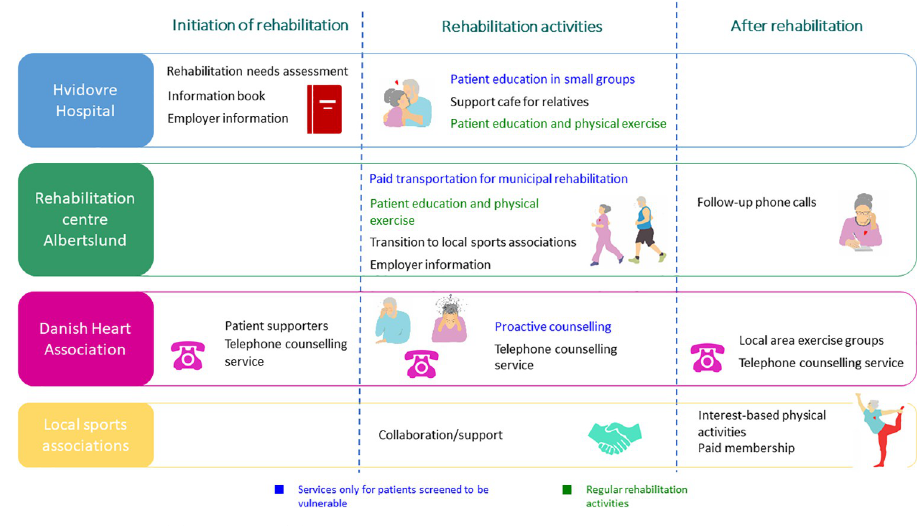
Fig 5. Overview of the content of the